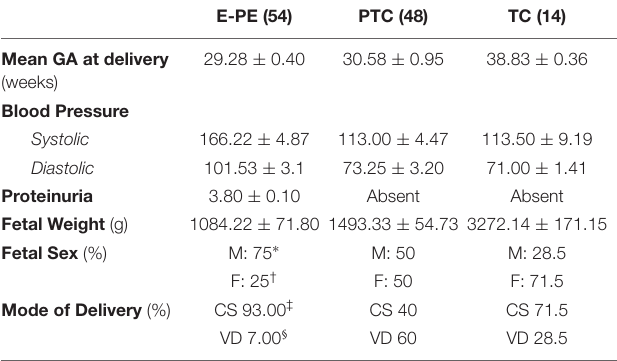
TABLE 1 | Clinical parameters of the study